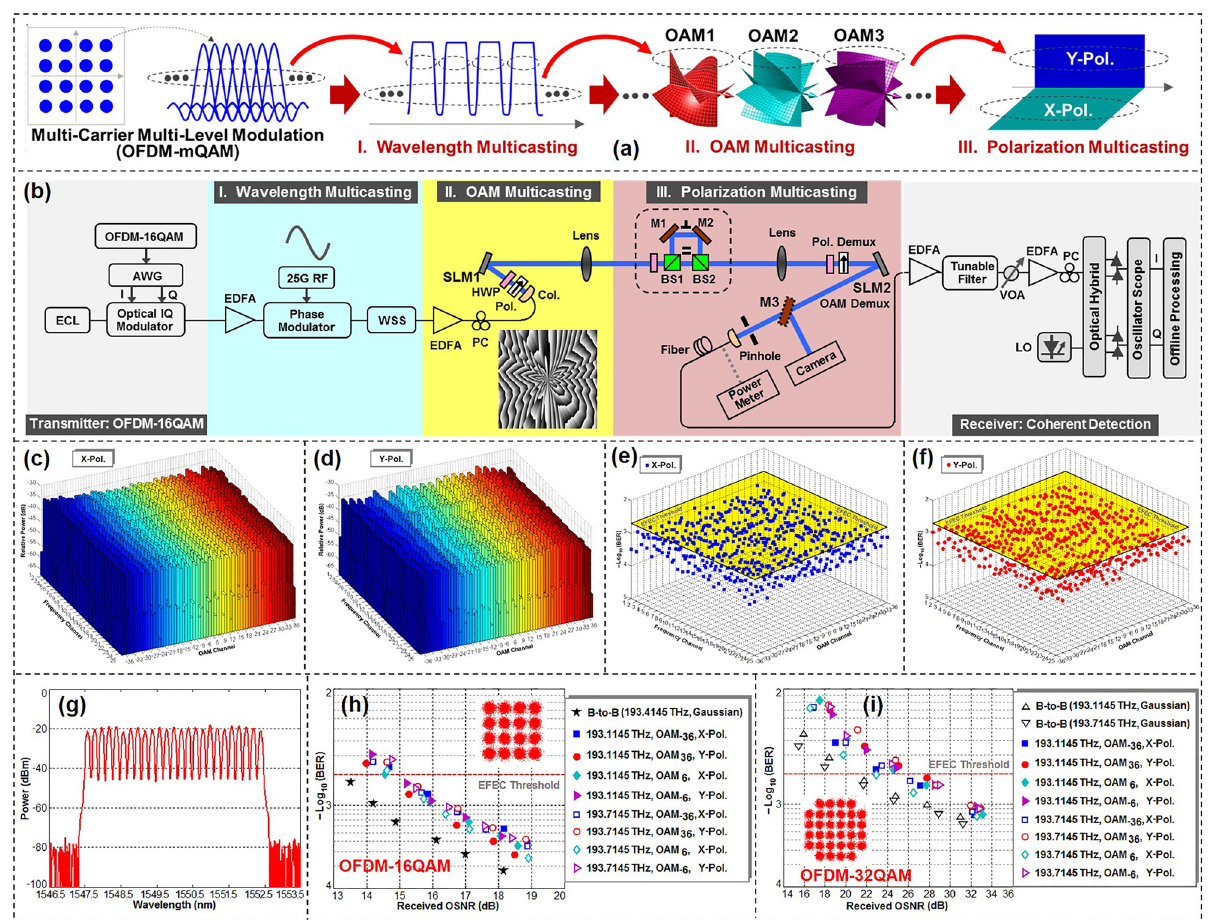
Figure 14: N -dimensional 1-to-1100 multicasting. (a)Conceptand(b)setupof N